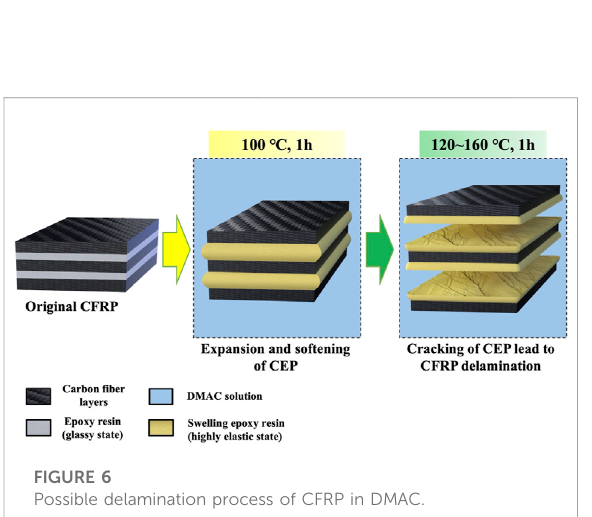
FIGURE 7 Images of the swelling products of the CEP cube treated at different